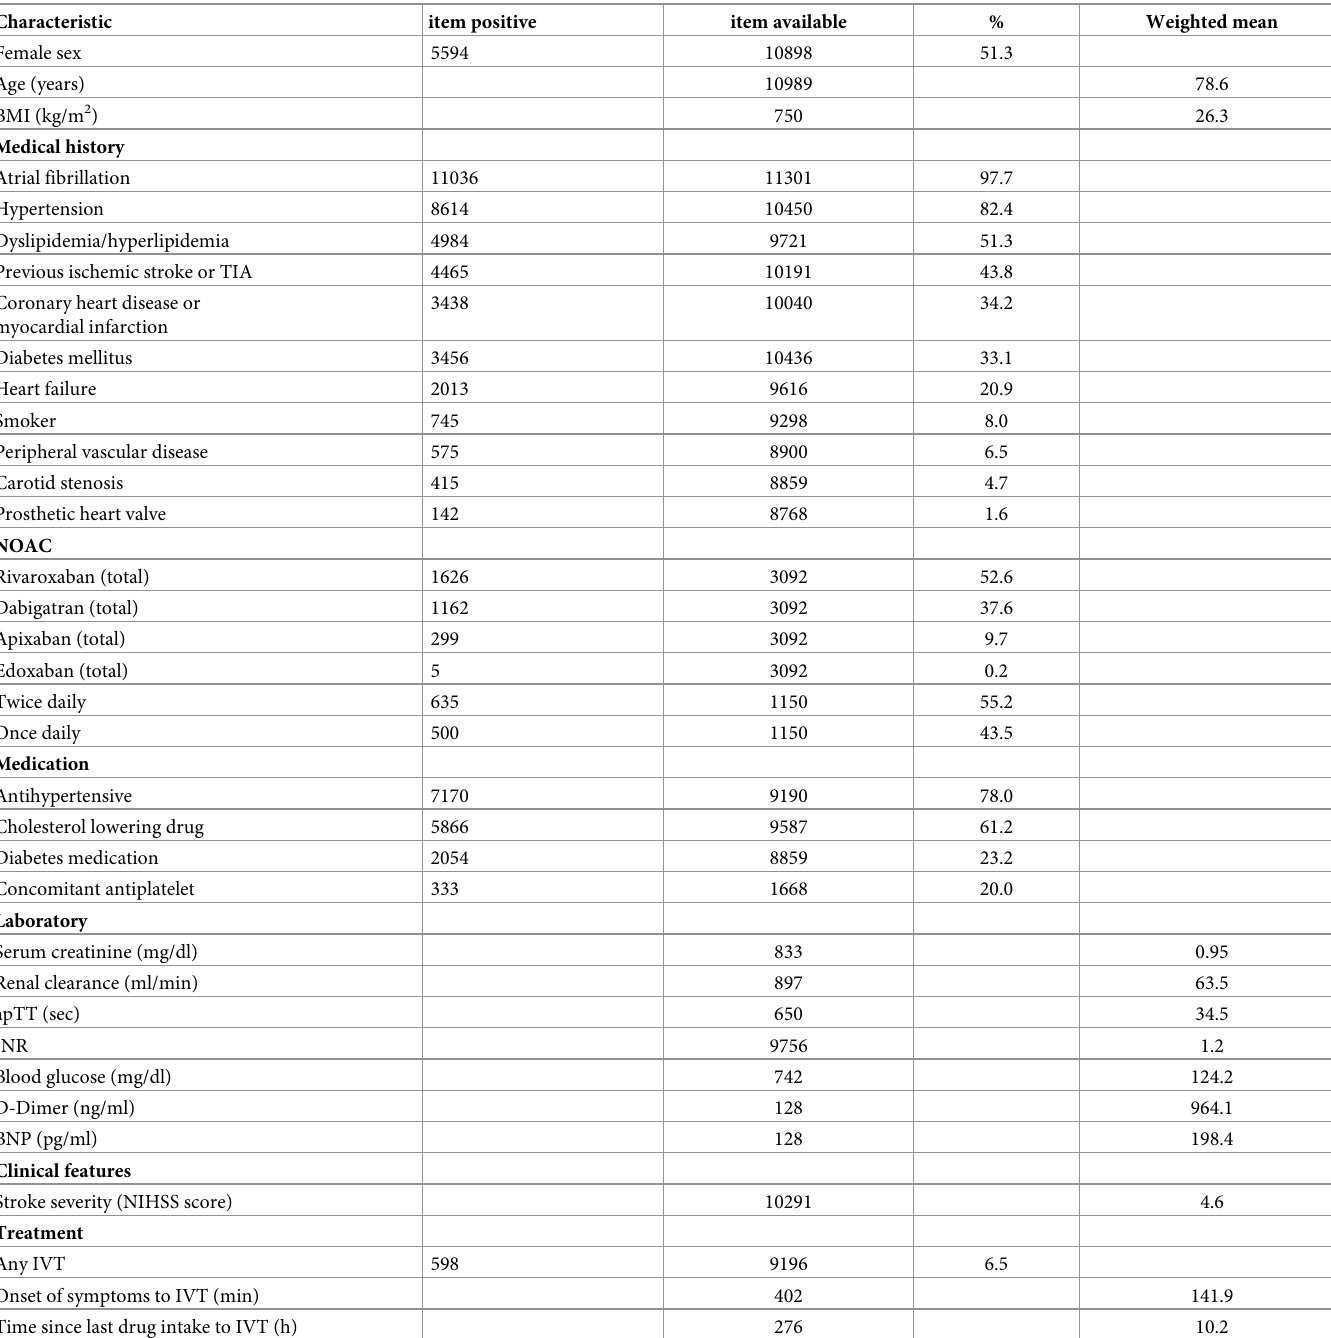
Table 1. Pooled characteristics of patients suffering acute cerebral ischemic events while taking non-vitamin K antagonist oral anticoagulants (N = 12247).